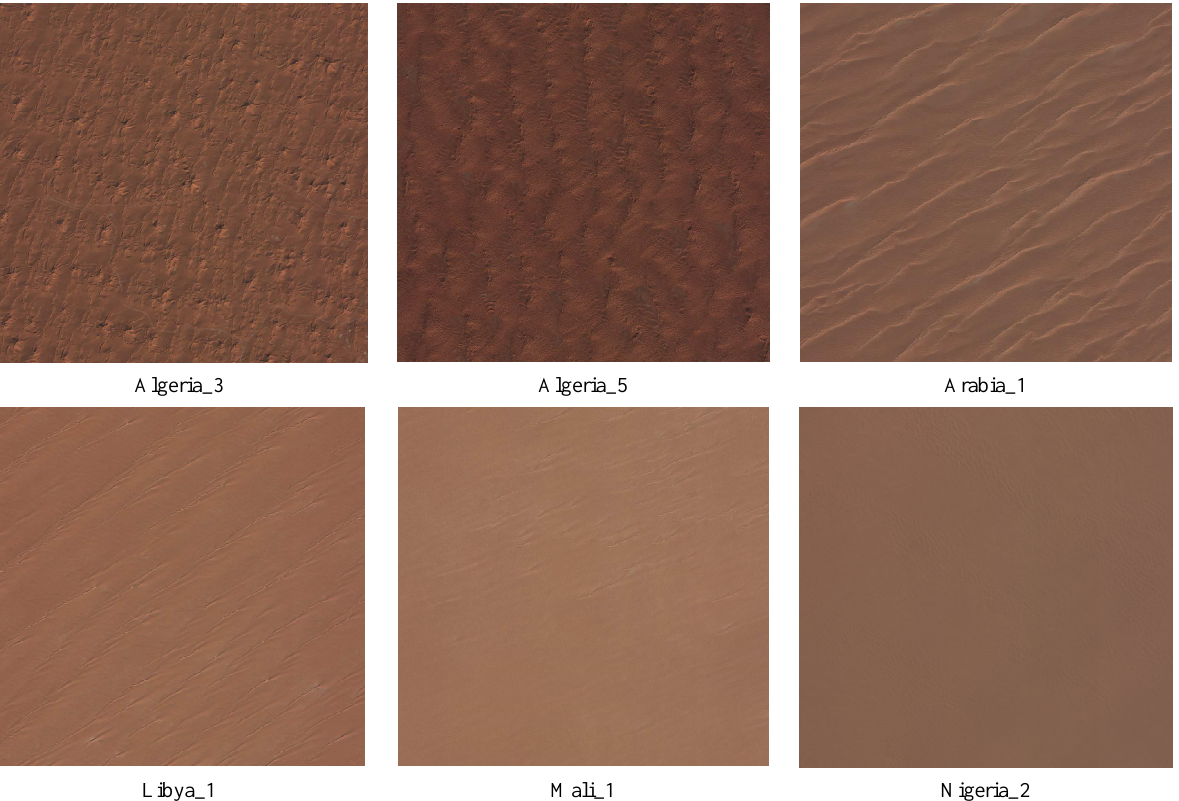
Figure 3. PLEIADES acquisitions of the six African desert sites used for its absolute calibration (coloured composition of the multispectral bands Blue, Green and Red).